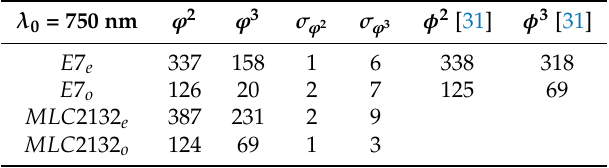
Table 1. GVD ( ϕ 2 ) and TOD ( ϕ 3 ) coefficients, for λ 0 = 750 nm, for E 7 and MLC 2132 on both axis. σ is the standard deviation of the fitted parameters. GVD ( φ 2 ) and TOD ( φ 3 ) values calculated from [31] are shown for comparison. GVD and TOD are respectively expressed in ( fs 2 / mm ) and ( fs 3 / mm ) . λ 0 = 750 nm ϕ 2 ϕ 3 σ ϕ 2 σ ϕ